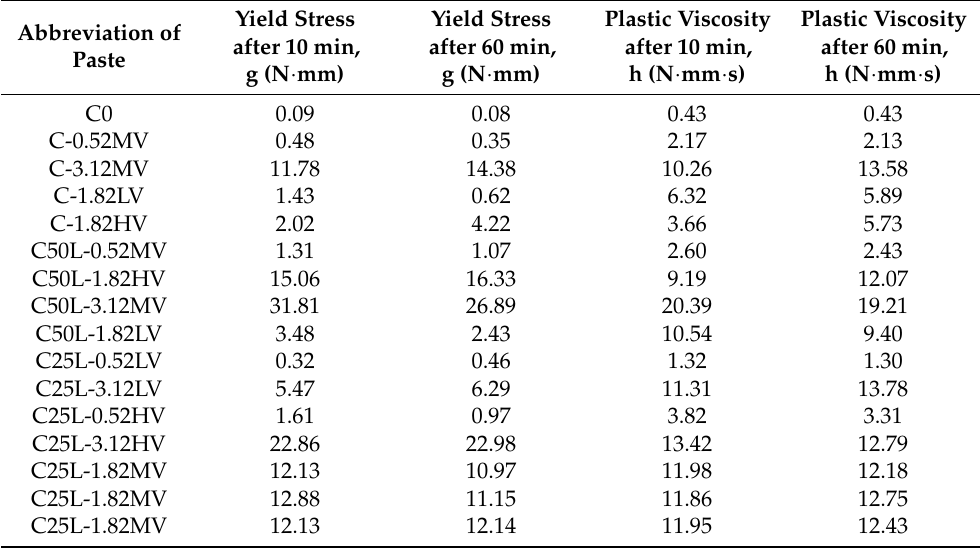
Table 8. Rheological